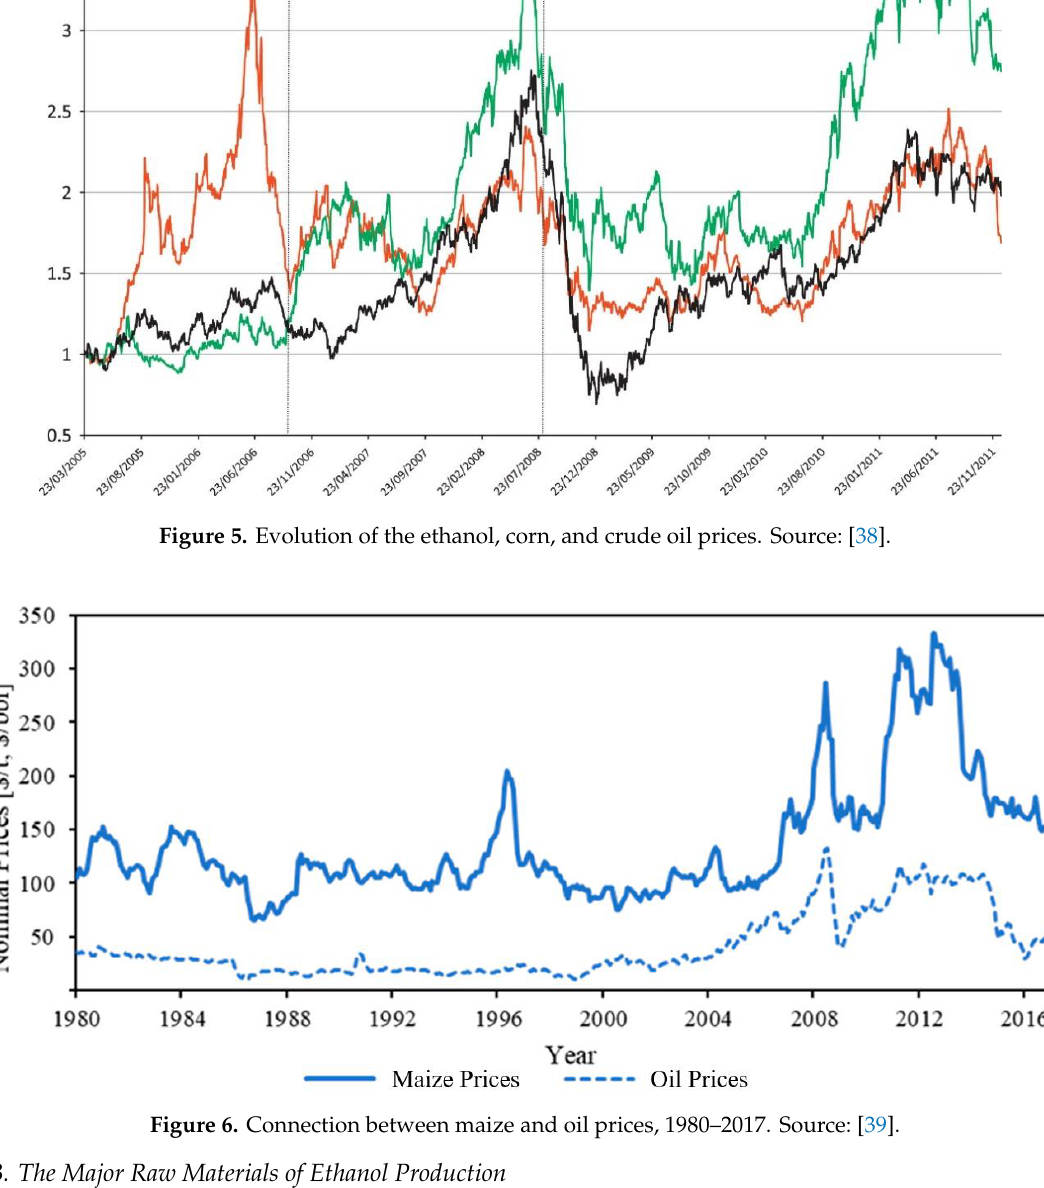
Figure 6. Connection between maize and oil prices, 1980–2017. Source: [39].